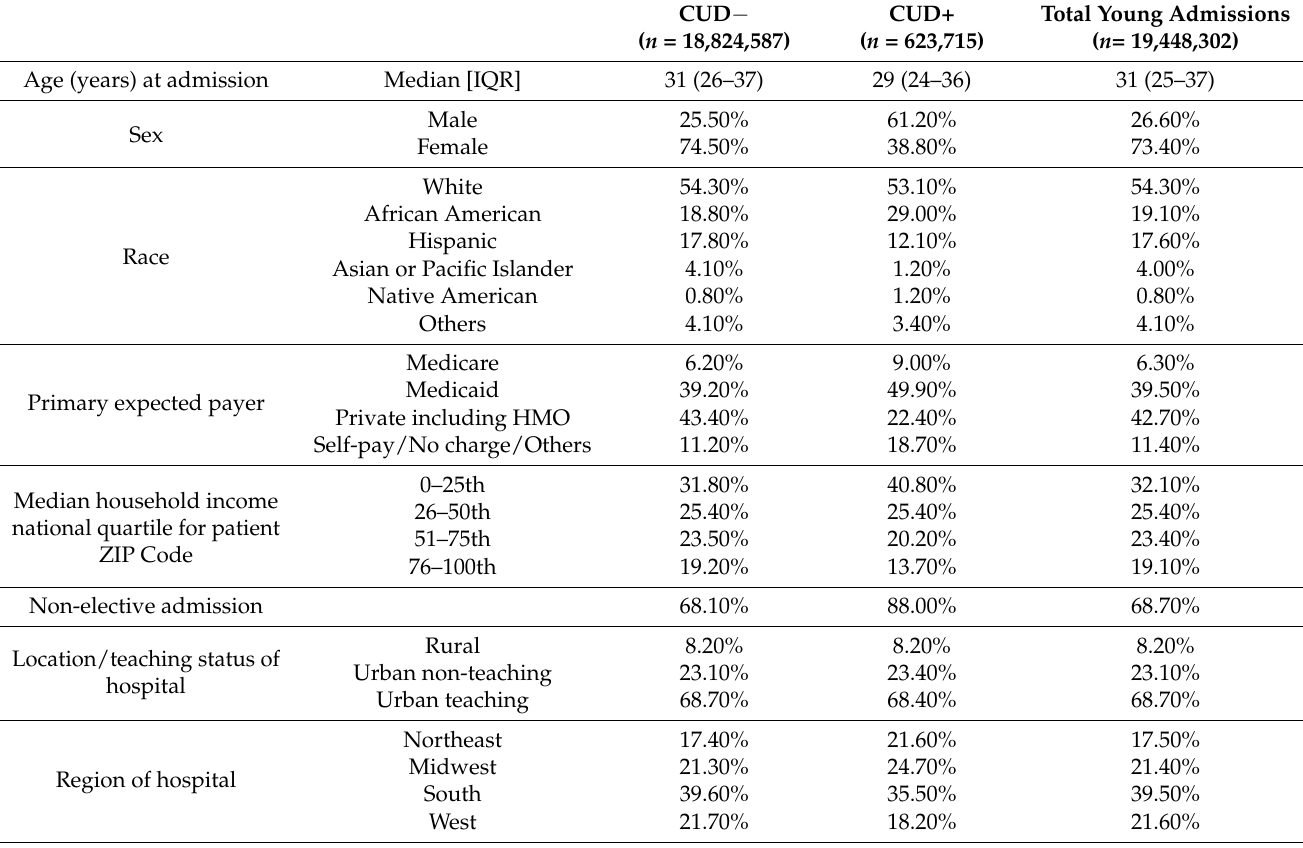
Table 1. Baseline Characteristics of Hospitalizations in Young (18–44 years) Patients with versus without Cannabis Use